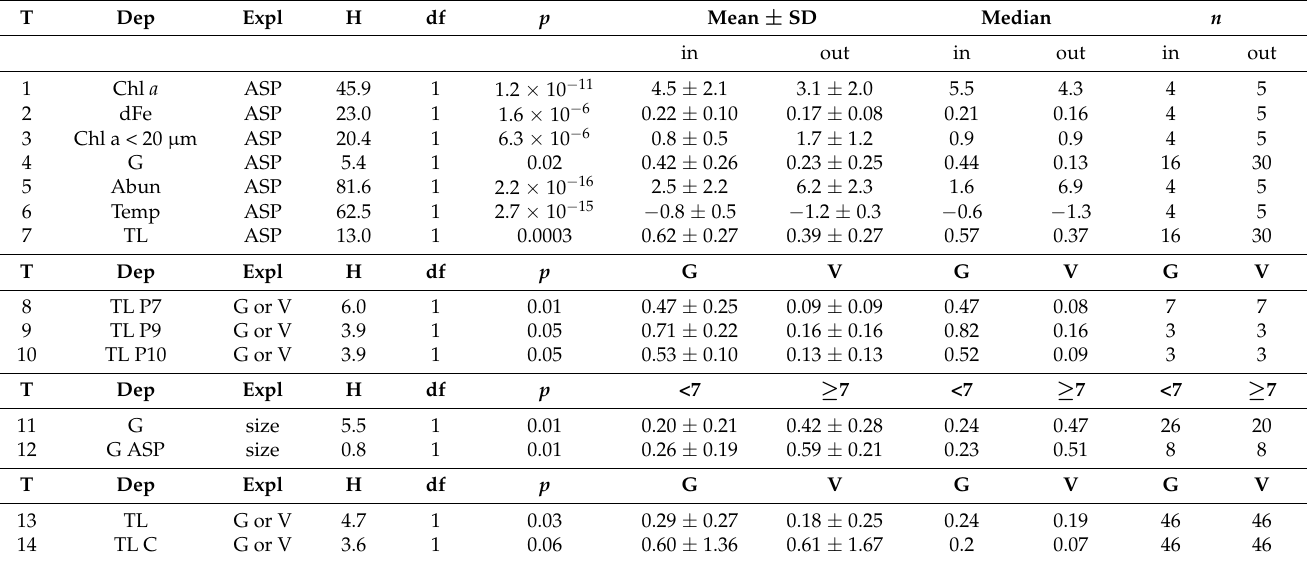
Table 3. Statistical data from Kruskal–Wallis testing. T = test number. Dep = dependent variables: